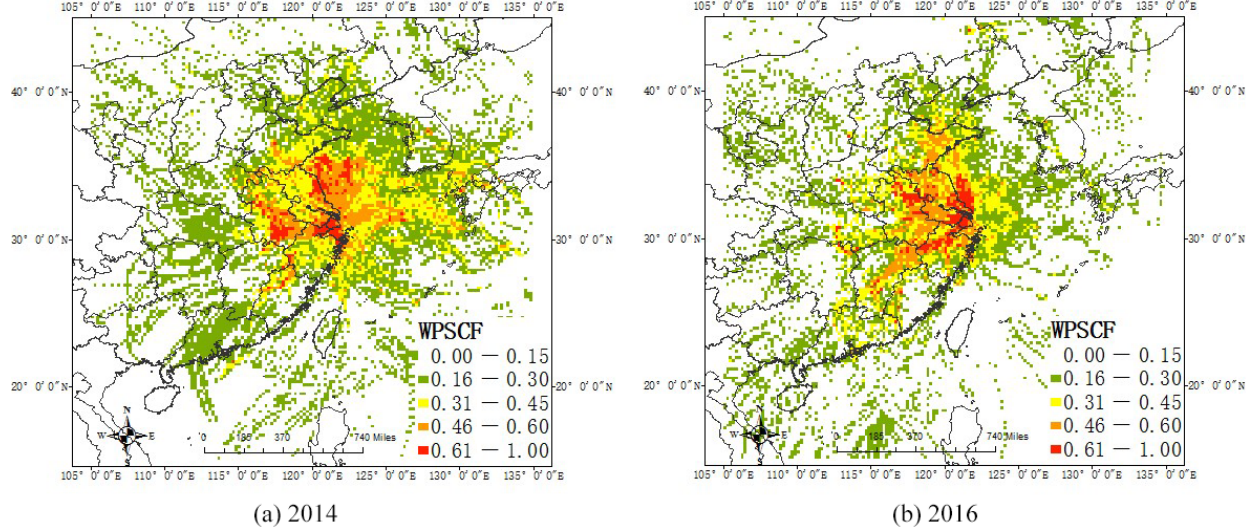
Figure 5. Source regions of GEM at the monitoring site from the PSCF model in (a) 2014 and (b) 2016.